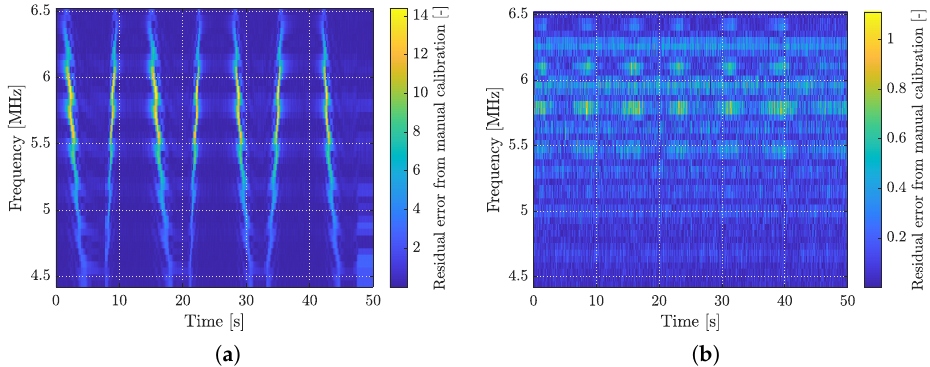
Figure 10. Residual between manual calibration and the layer phase-lag regression model. ( a ) Test 1. ( b ) Test